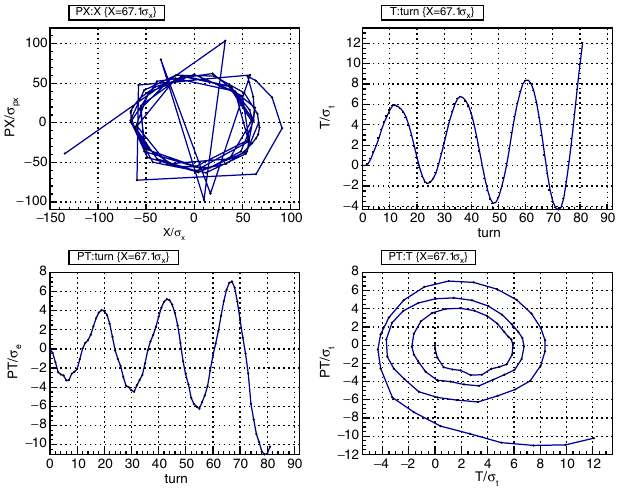
0 ;p 0 ; σ ¼ 0 ; ;y ¼ 0 ;p x x ¼ y ¼